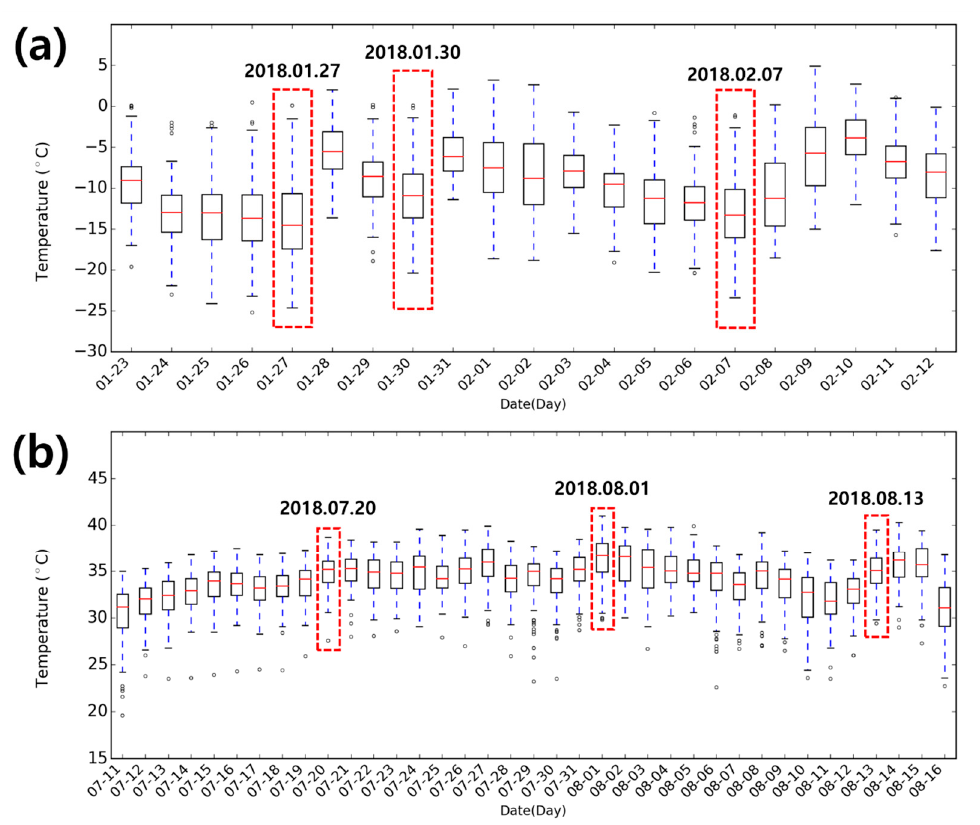
Figure 6. Time series boxplots of ( a ) T MN of 79 ASOS stations during the cold wave period from January 23 to February 13 and ( b ) T MX of 79 ASOS stations during the heat wave period from July 11 to August 16 in 2018 [46].